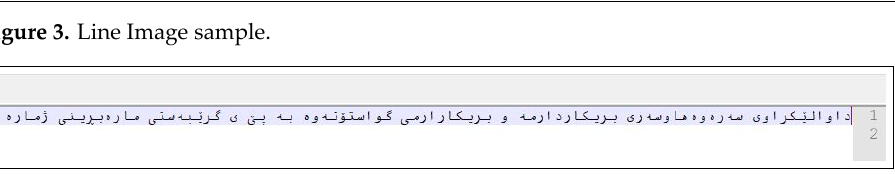
Figure 4. Ground Truth transcription